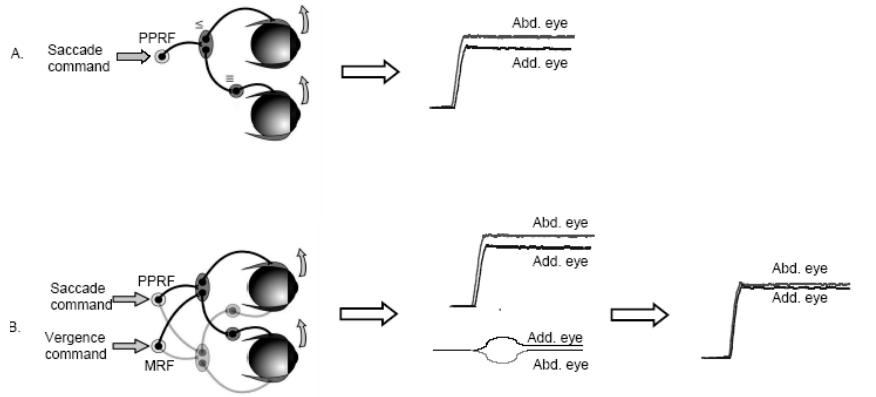
Figure1. A. Hering’s view: The lateral rectus of the abducting eye and the contralateral medial rectus of the adducting eye receive an equal saccadic command. Asymmetry of viscoelastic properties of muscles and/or delay in innervation cause unequal saccades. B. Hypothesis: A small vergence command is sent together with the saccades, compensating the peripheral asymmetries. PPRF: paramedian pontine reticular formation. MRF: mesencephalic reticular formation. III: oculomotor nucleus. IV: abducens nucleus. Note that the pathway for vergence is